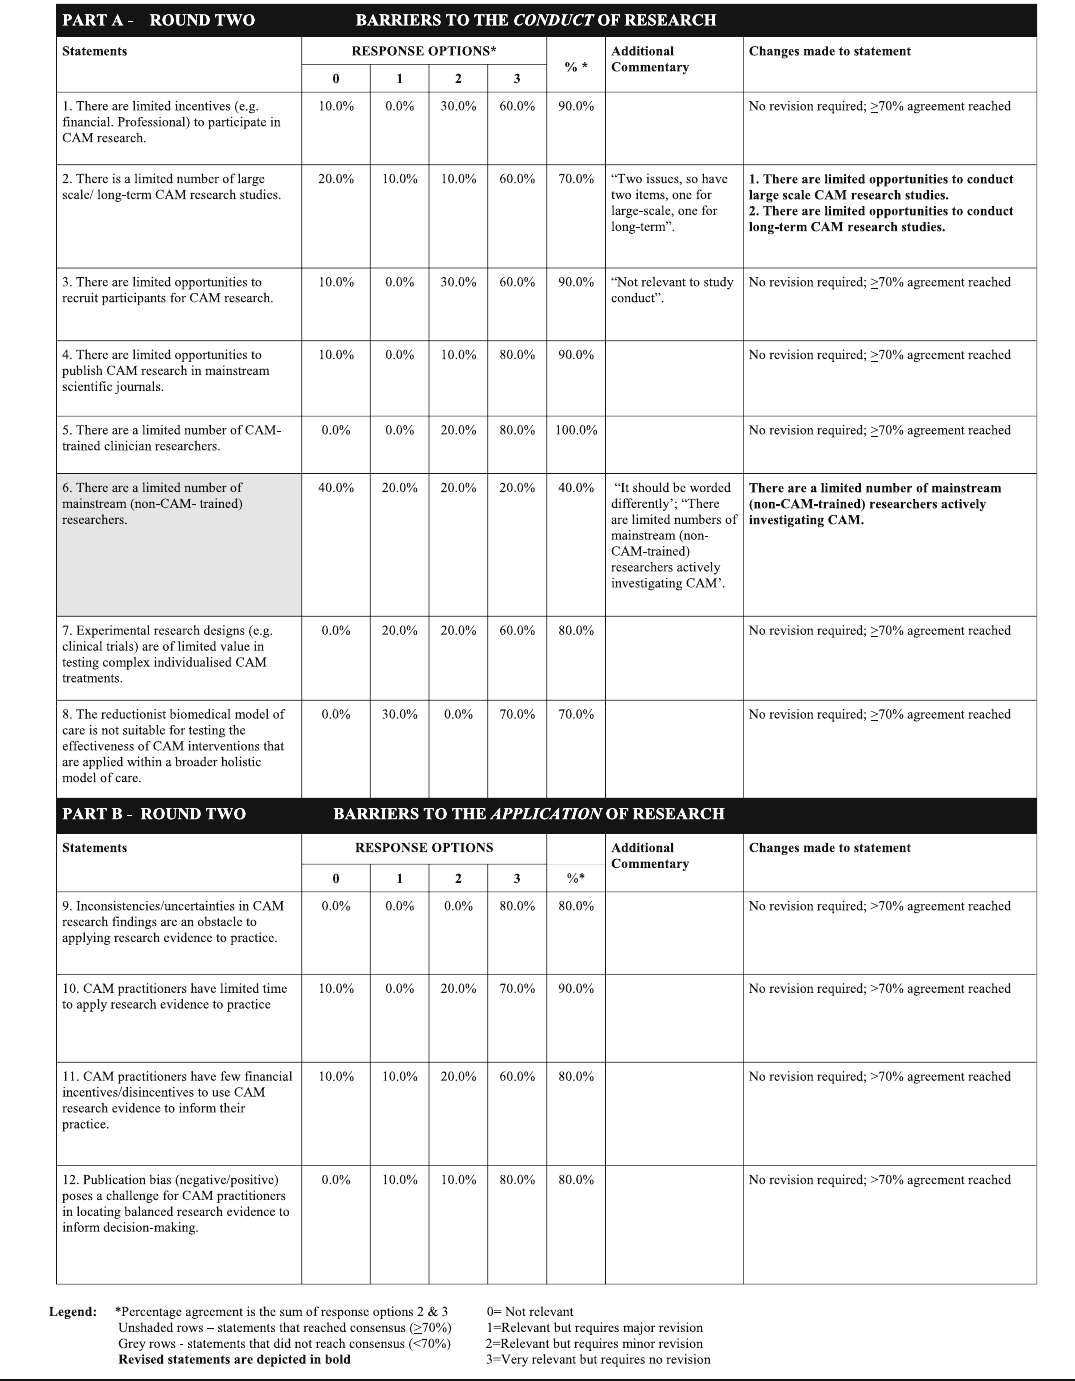
Table 4 Overview of participant responses to part A and part B items from round